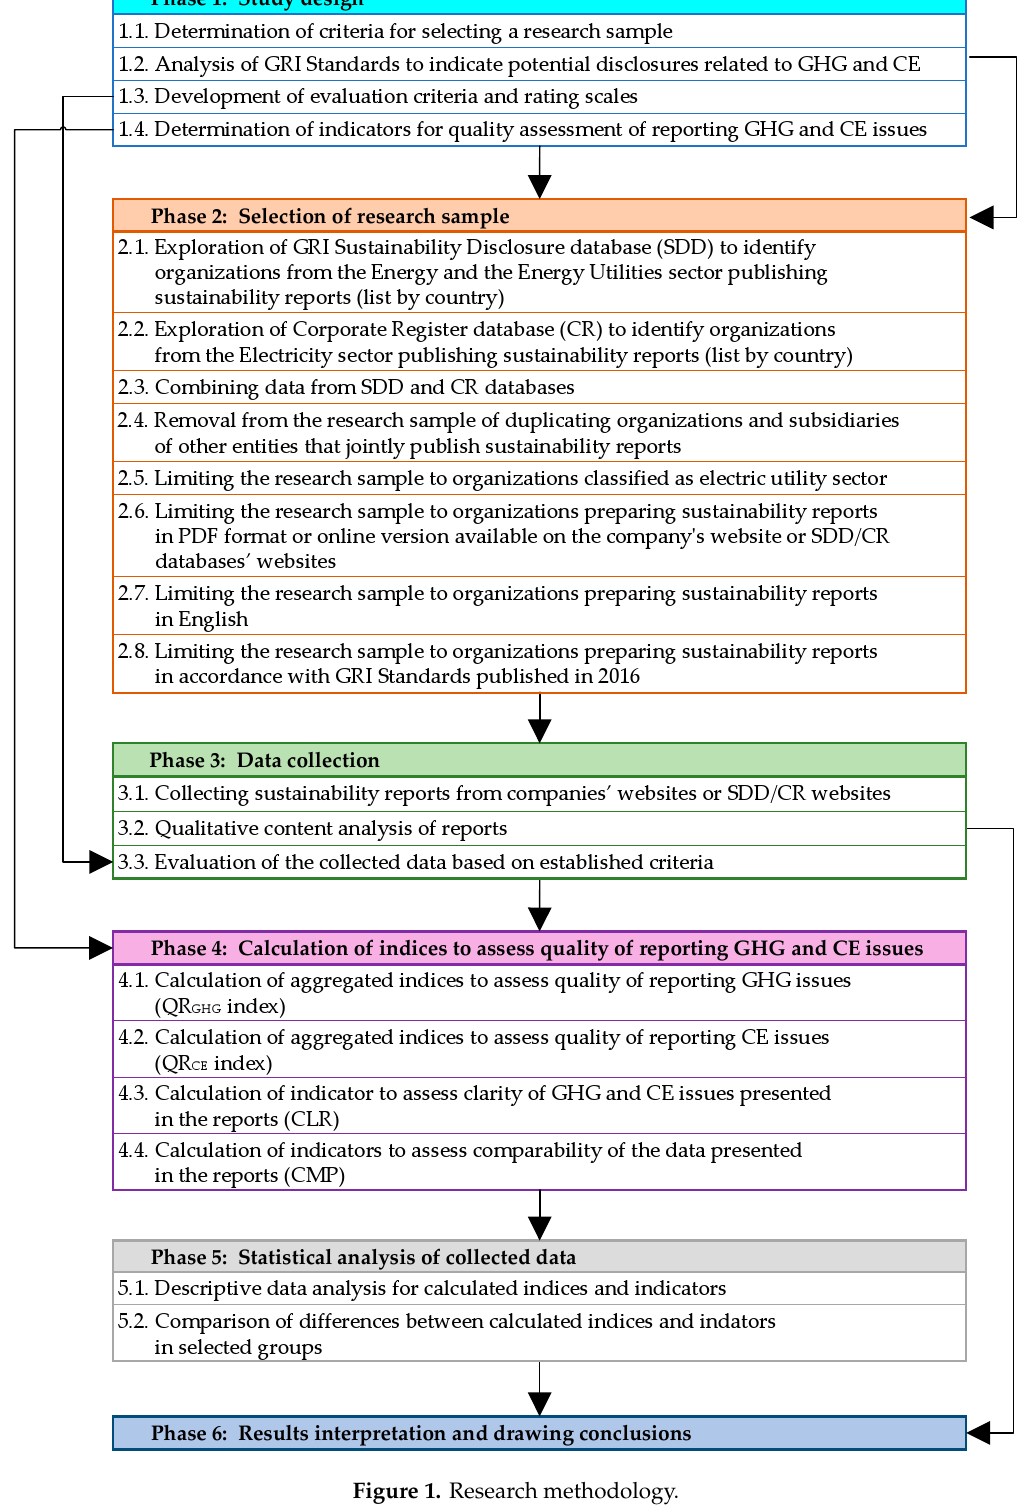
Figure 1. Research methodology.